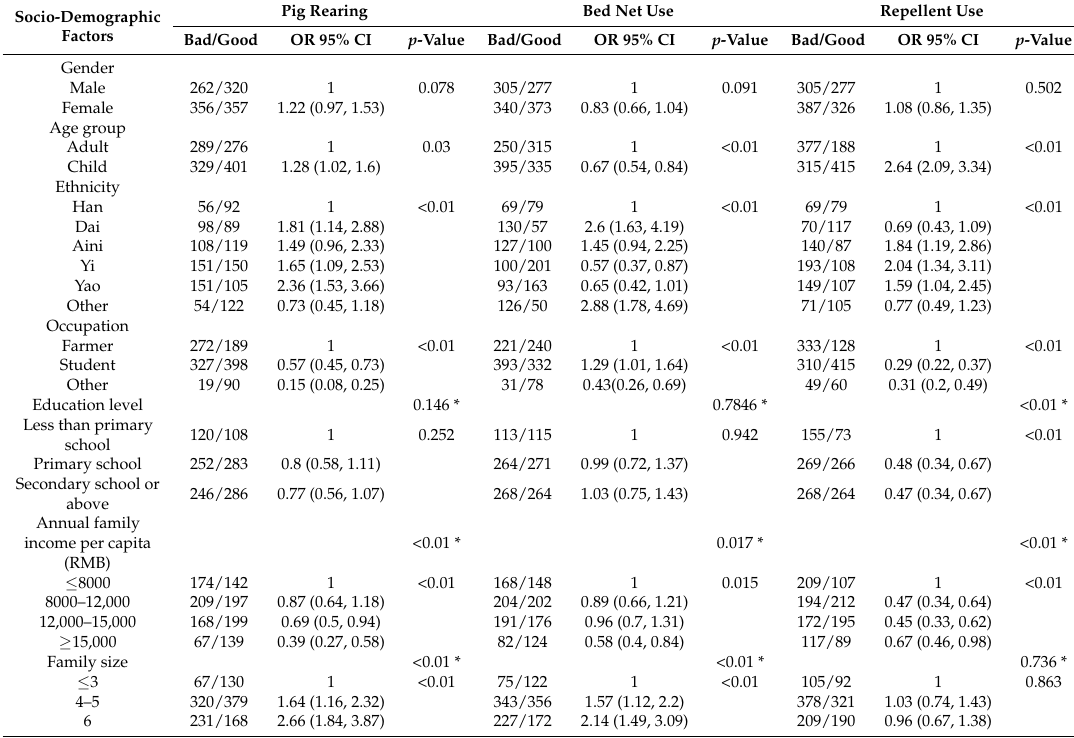
Table 3. Univariate analysis of association between the sociodemographic factors and pig rearing, bed net use, and repellent